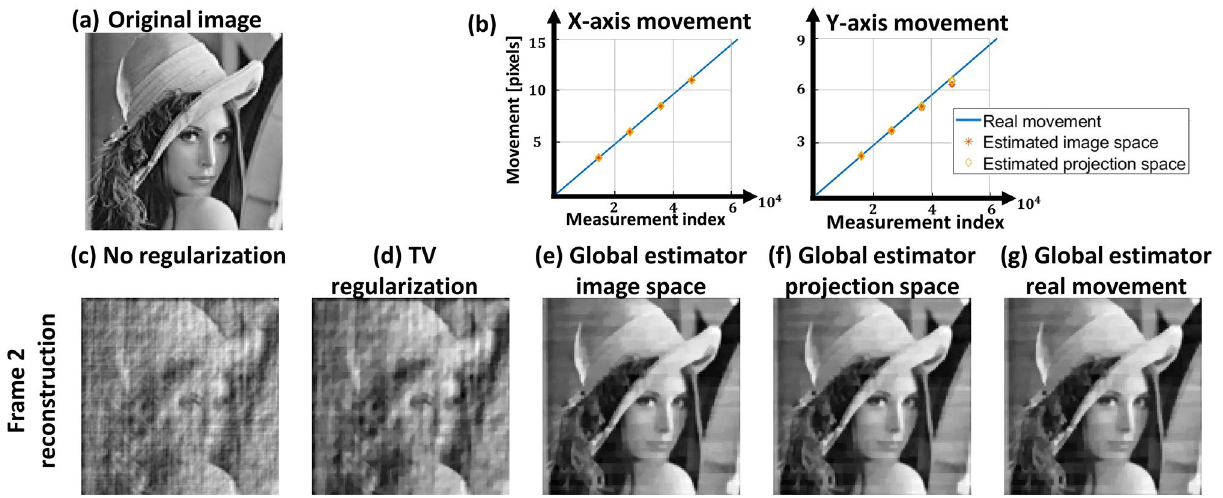
Figure 3. Reconstruction of Lena image undergoing translation at constant velocity. ( a ) The original Lena image. ( b ) Movement of the image during measurements and estimated movement. ( c – g ) Reconstruction of the second frame with different reconstruction algorithms.